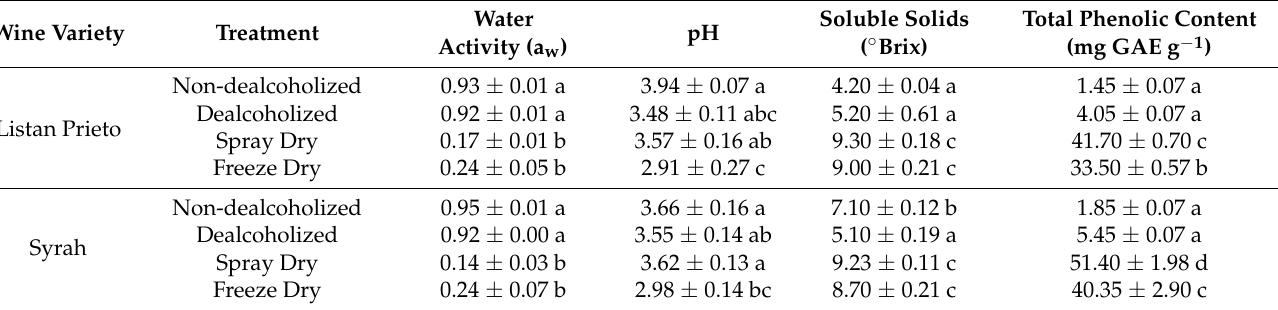
Table 1. Physicochemical parameters and total phenolic content of treated wine